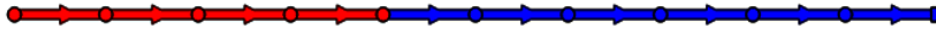
Figure 7. The net model of a straight microchannel. The red color shows the water distribution in the microchannel at the time of 2 s after the start of displacement.